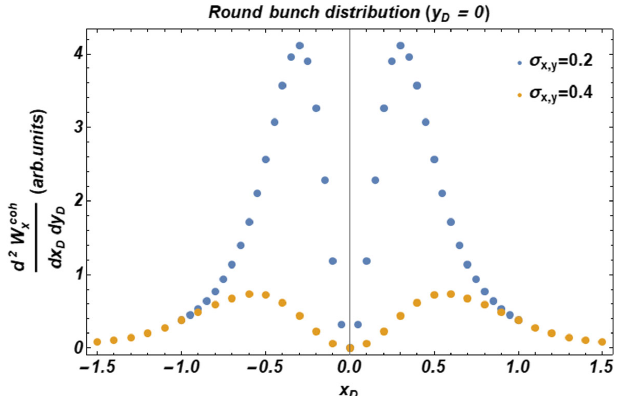
FIG. 15. COTR distribution calculated for an azimuthally symmetric bunch.